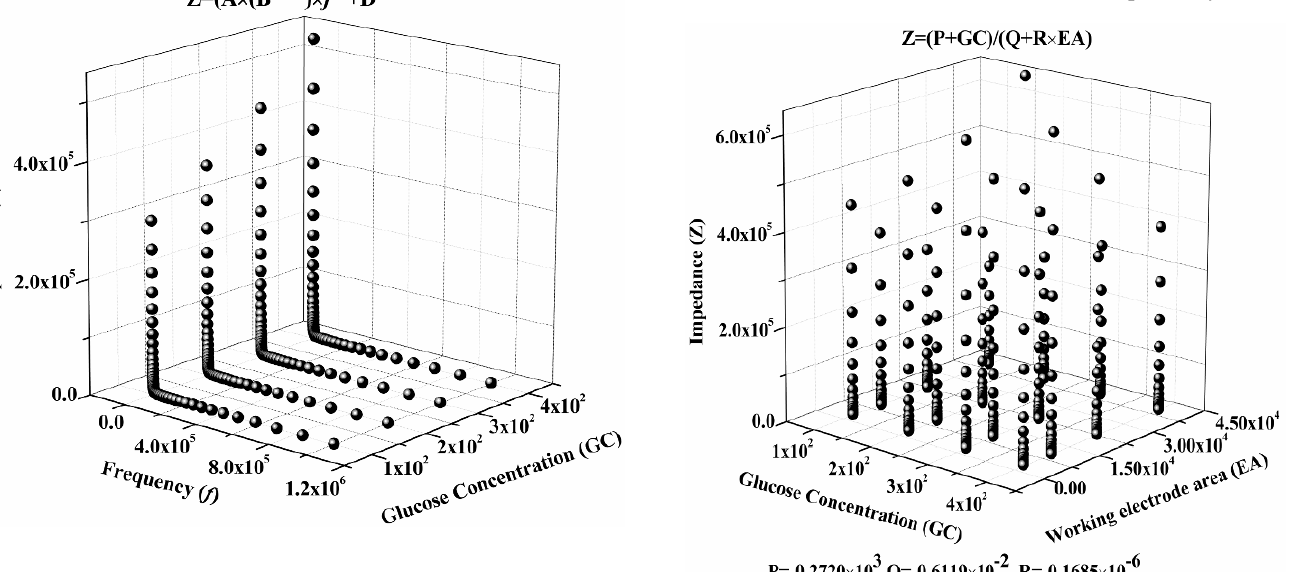
Fig. 7: Dependence plot of impedance with respect to scanning frequency and glucose concentration.